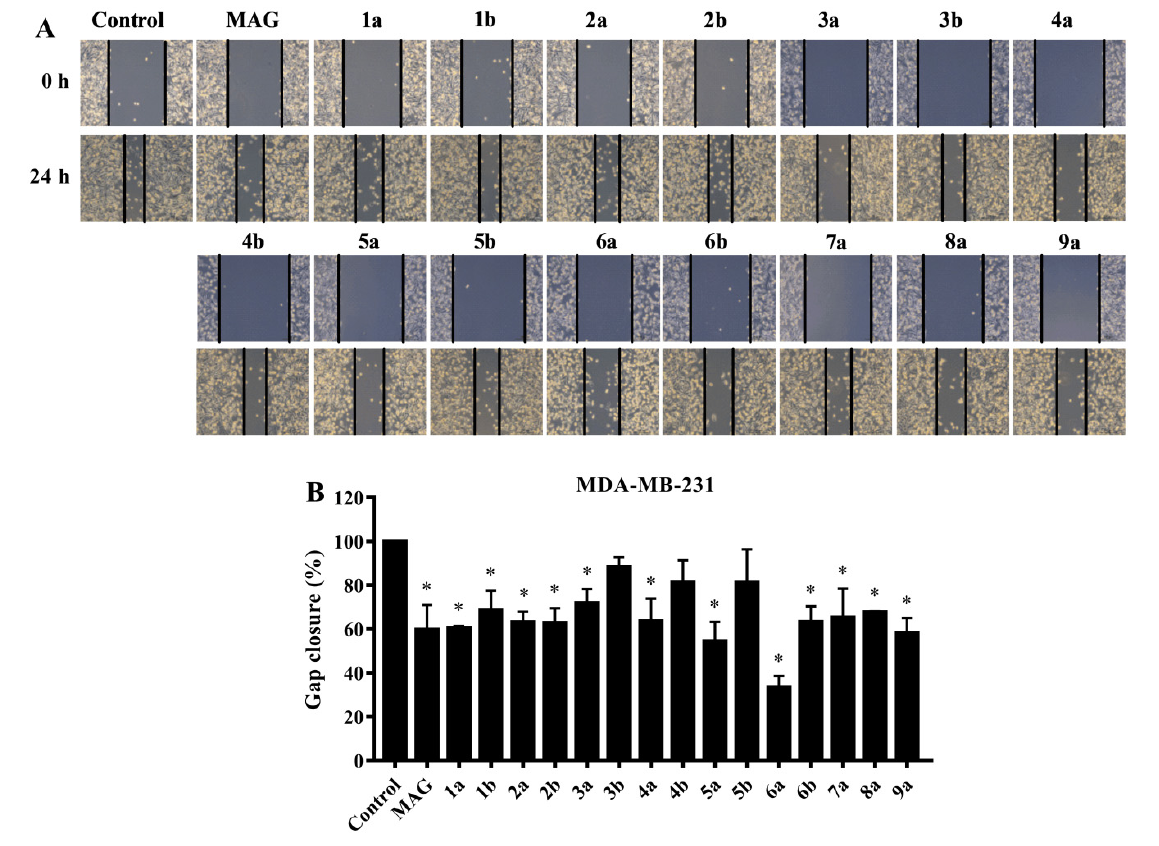
Figure 1. Preliminary screening of the effects of the MAG derivatives on the migration of MDA-MB-231 cells by a wound- healing assay. ( A ) MDA-MB-231 cells were seeded in a 6-well plate at a density of 6 × 10 5 cells per well and exposed to the MAG derivatives (10 µ M) for 24 h. ( B ) Quantification analysis presented as the mean ± standard deviation. * p < 0.05 ( n = 3).